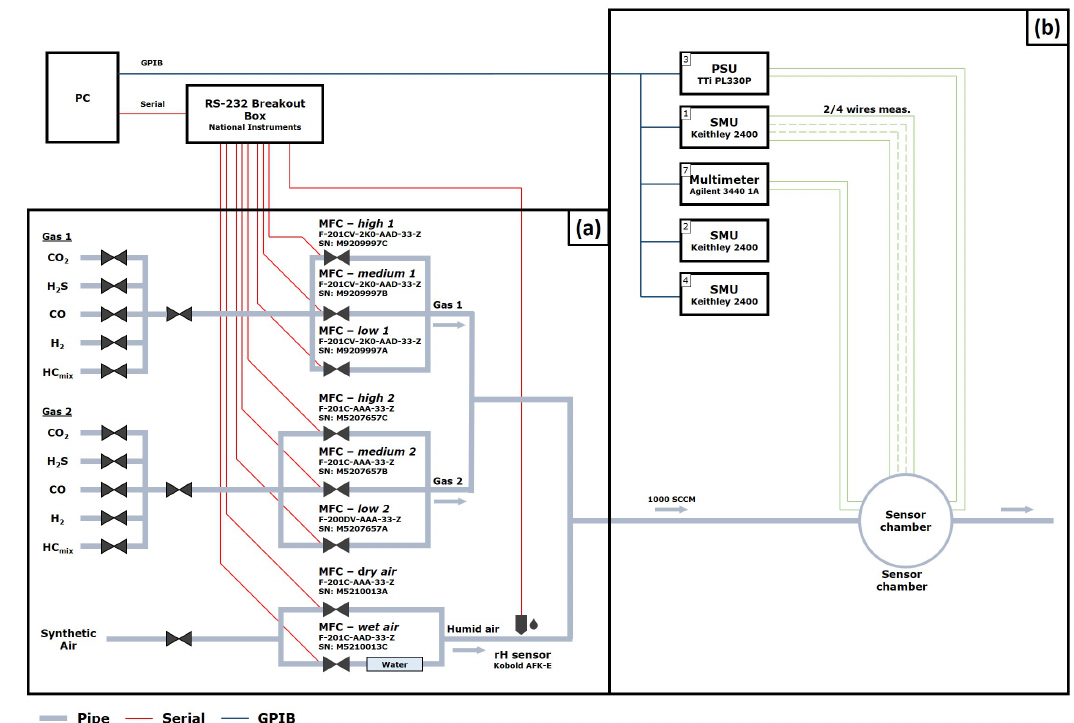
Figure A1. Gas measurement set-up: ( a ) gas atmospheric part, ( b ) electrical evaluation